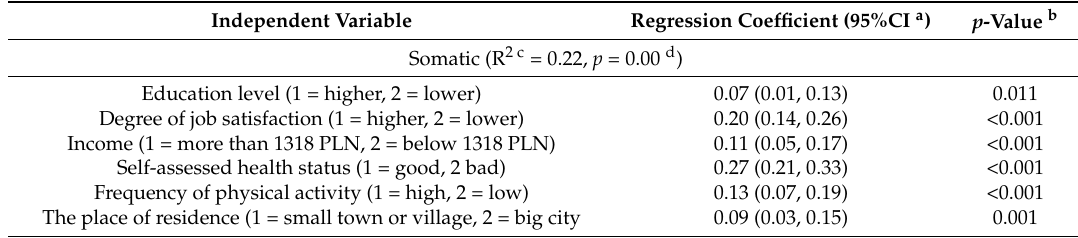
Table 5. Results of multivariable analysis for the relation between QoL domains and particular independent variables ( N =